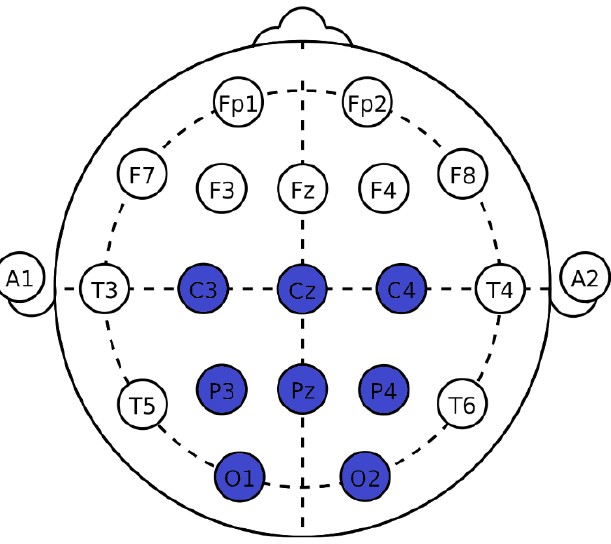
Figure 5. Electrode placement (highlighted electrodes are used in this study).